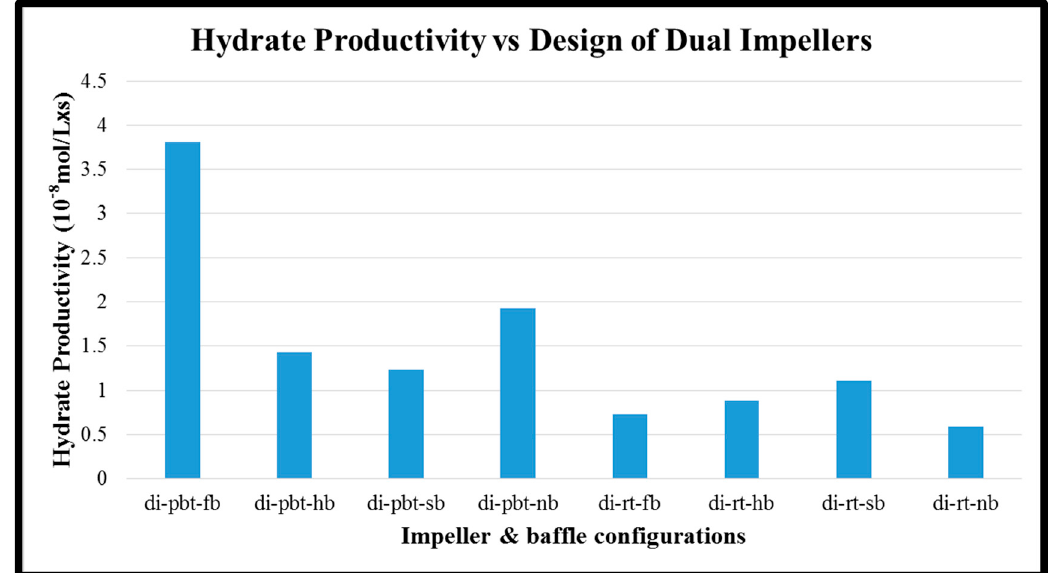
Figure 12. Hydrate productivity of dual impeller experiments.